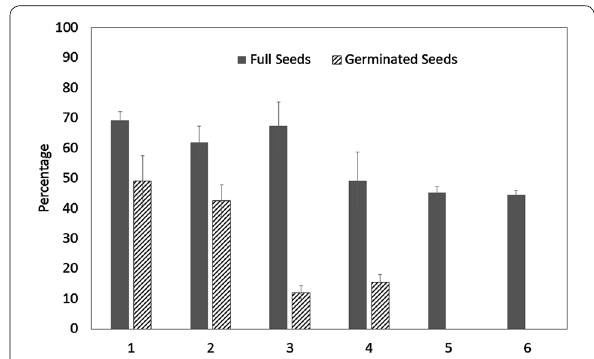
Fig. 4 Germination percentage of mature seeds of Angraecum protensum originating from different seed capsules collected from Itremo, Central Highlands, Madagascar. Each numbered bar represents